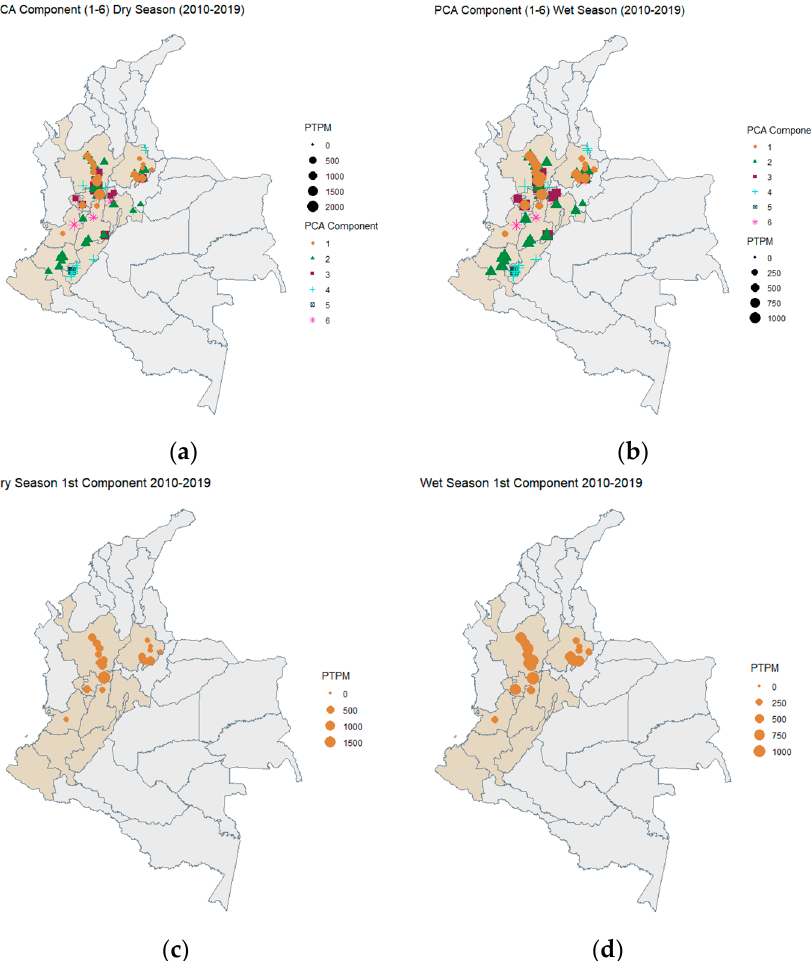
Figure 6. PCA results for seasonal periods ( a ) for dry in 1st–6th components; ( b ) for wet in 1st–6th components; ( c ) for dry in 1st component; ( d ) for wet in 1st component. Source: author’s pro- cessing.